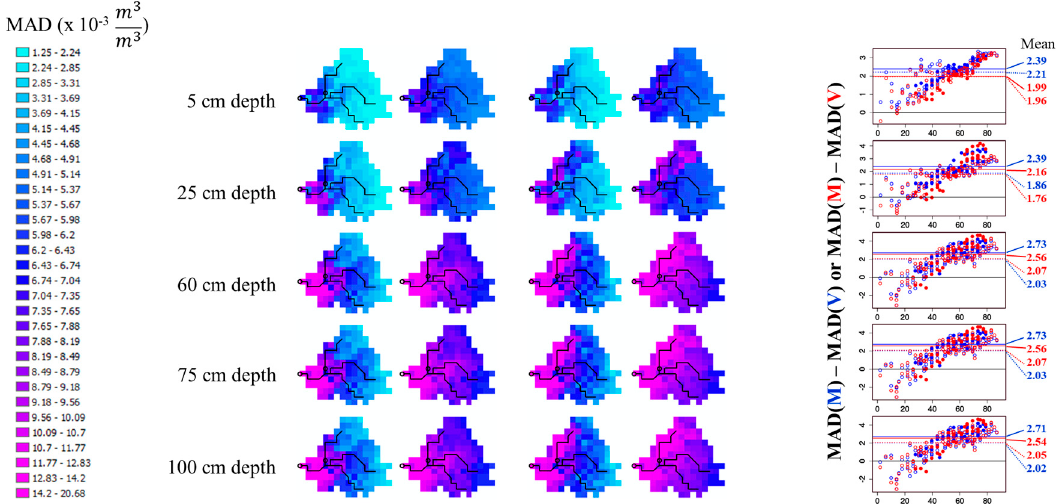
Figure 6. Same as Figure 5 but for depth-specific soil moisture translated from SAC-states via the soil moisture translation routine available in the SAC-HT. The bottom panel of Figure 8 shows box plots of (cid:1850) (cid:3024)(cid:3020)(cid:3022)(cid:3019)(cid:3007) (cid:3364)(cid:3364)(cid:3364)(cid:3364)(cid:3364)(cid:3364)(cid:3364)(cid:3364) and (cid:1850) (cid:3024)(cid:3008)(cid:3019)(cid:3015)(cid:3005) (cid:3364)(cid:3364)(cid:3364)(cid:3364)(cid:3364)(cid:3364)(cid:3364)(cid:3364) at the scale of the entire basin Tiff City and the sub-basin Lanagan. At both Tiff City and Lanagan, MVAR produced notably smaller mean and value range of (cid:1850) (cid:3024)(cid:3020)(cid:3022)(cid:3019)(cid:3007) (cid:3364)(cid:3364)(cid:3364)(cid:3364)(cid:3364)(cid:3364)(cid:3364)(cid:3364) ( (cid:1827) ○ (cid:1828) ○ (cid:1827) ● (cid:1828) ● in Figure 8) than VAR ( (cid:1827) ○ (cid:1828) ○ (cid:1827) ● (cid:1828) ● ) at both flow assimilation cases. In contrast, differences in (cid:1850) (cid:3024)(cid:3008)(cid:3019)(cid:3015)(cid:3005) (cid:3364)(cid:3364)(cid:3364)(cid:3364)(cid:3364)(cid:3364)(cid:3364)(cid:3364) are marginal except outliers at Tiff City ( (cid:1829) ○ (cid:1829) ○ (cid:1830) ○ (cid:1830) ○ at the top right box plot in Figure 8). Figures 7 and 8 suggest that, although MVAR generally reduces the effect of (cid:1798) (cid:3024) on model states by possibly reducing the degree of compensating for unresolved MFB by (cid:1798) (cid:3024) , improving model fidelity to physical realism may precede an assimilation procedure in order to pose the assimilation problem well-posed [34]. When assimilating interior flows in addition to outlet flow, (cid:1850) (cid:3024)(cid:3020)(cid:3022)(cid:3019)(cid:3007) (cid:3364)(cid:3364)(cid:3364)(cid:3364)(cid:3364)(cid:3364)(cid:3364)(cid:3364) and (cid:1850) (cid:3024)(cid:3008)(cid:3019)(cid:3015)(cid:3005) (cid:3364)(cid:3364)(cid:3364)(cid:3364)(cid:3364)(cid:3364)(cid:3364)(cid:3364) values within Lanagan ( ● and ● at the